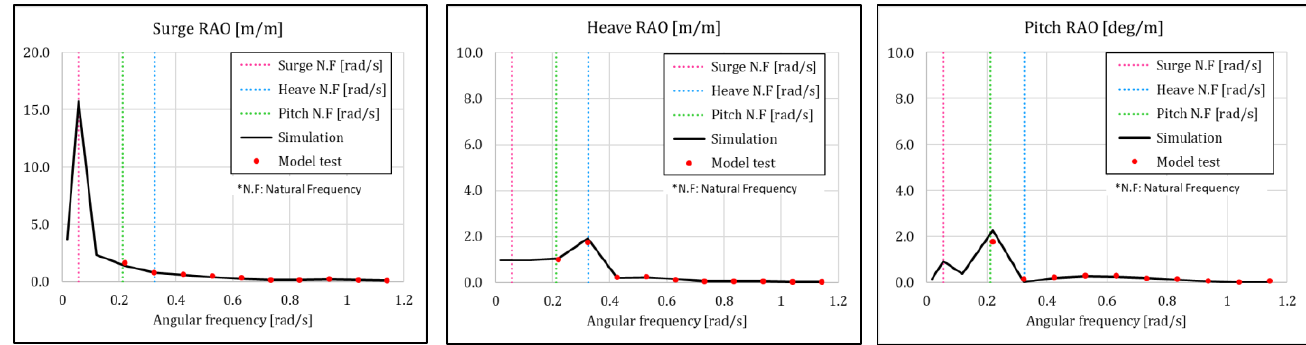
Figure 9. LC2 RAO result under wind and regular waves.